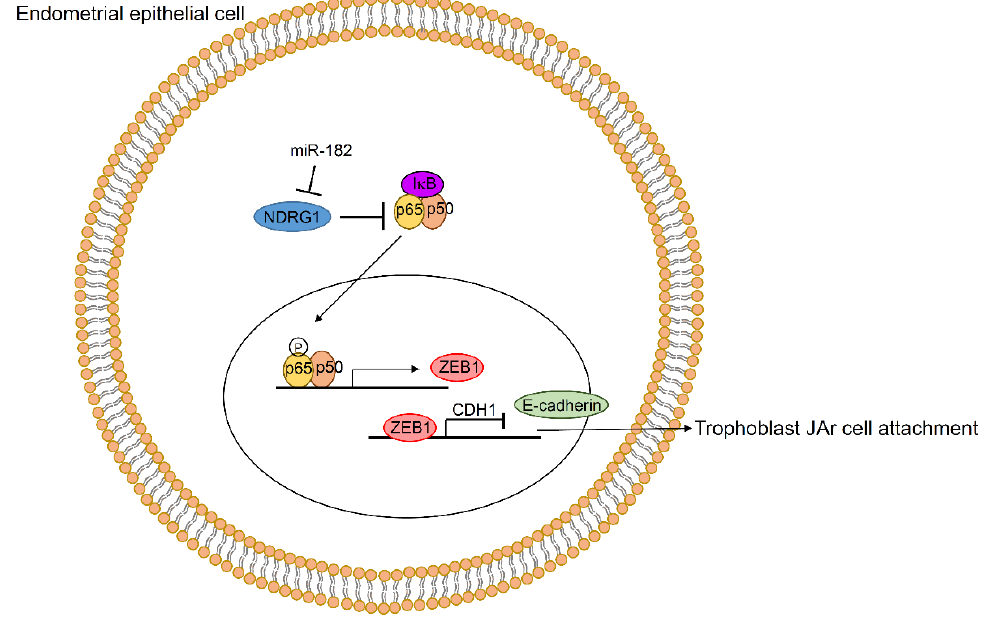
Figure 6. Proposed developmental mechanism for endometrial receptivity disorders, based on miR-182-5p-mediated downregulation of the NDRG1/NF- κ B/ZEB1/E-cadherin pathway.